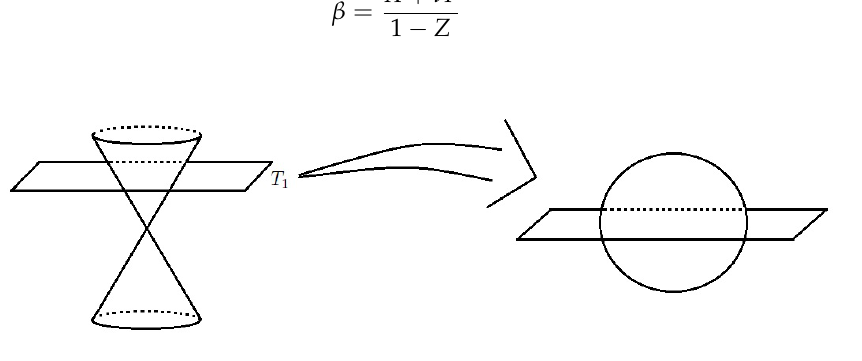
Figure 1. Interception of the light-cone, leading to the Riemann sphere.